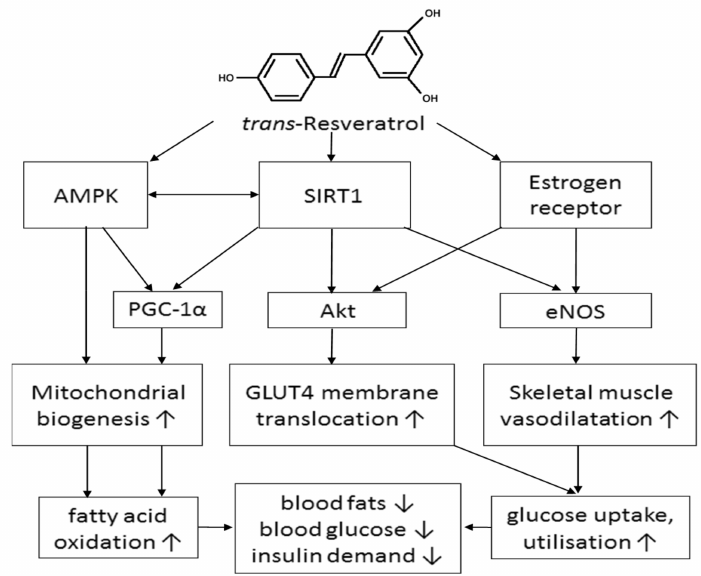
Figure 1. Multiple mechanisms by which resveratrol may counteract insulin resistance: activation of AMP-activated protein kinase–human sirtuin 1 (AMPK–SIRT1) pathways to enhance